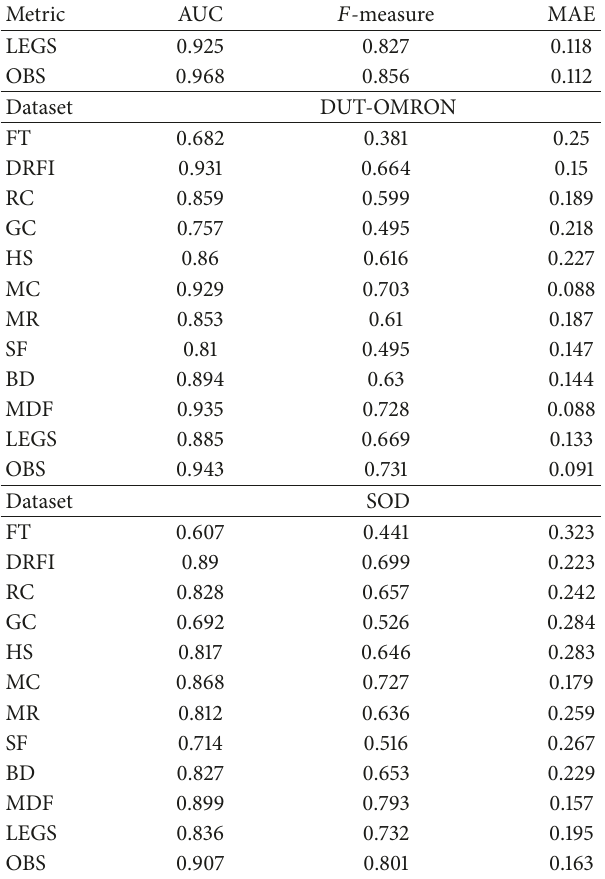
Table 3: 𝐹 -measure, AUC, and MAE of OBS and 11 state-of-the-art methods on six state-of-the-art